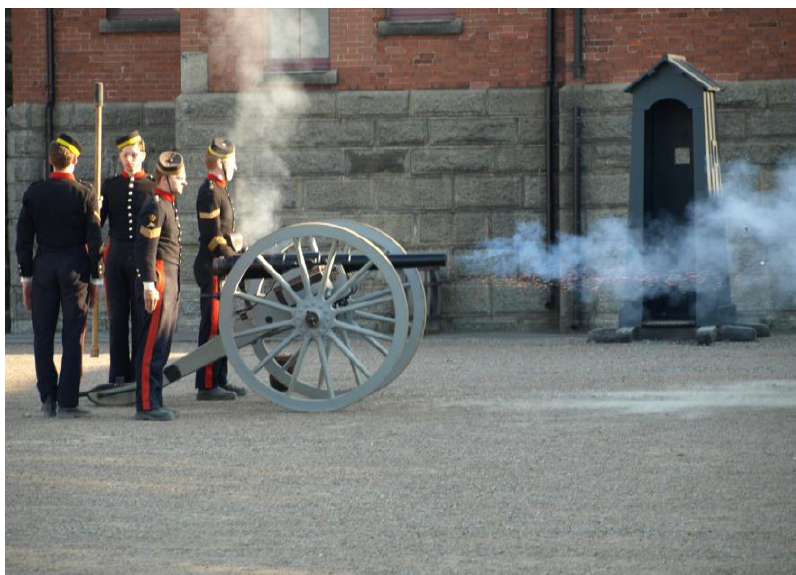
Figure 3. The 78 th Highlanders (Halifax-Citadel) demonstrate the firing of a field gun in close proximity to symposium attendees. We were all apprehensive when, after firing their first two shots, they pivoted the cannon, rushed towards us, and fired two more deafening shots. No scientists were harmed in this